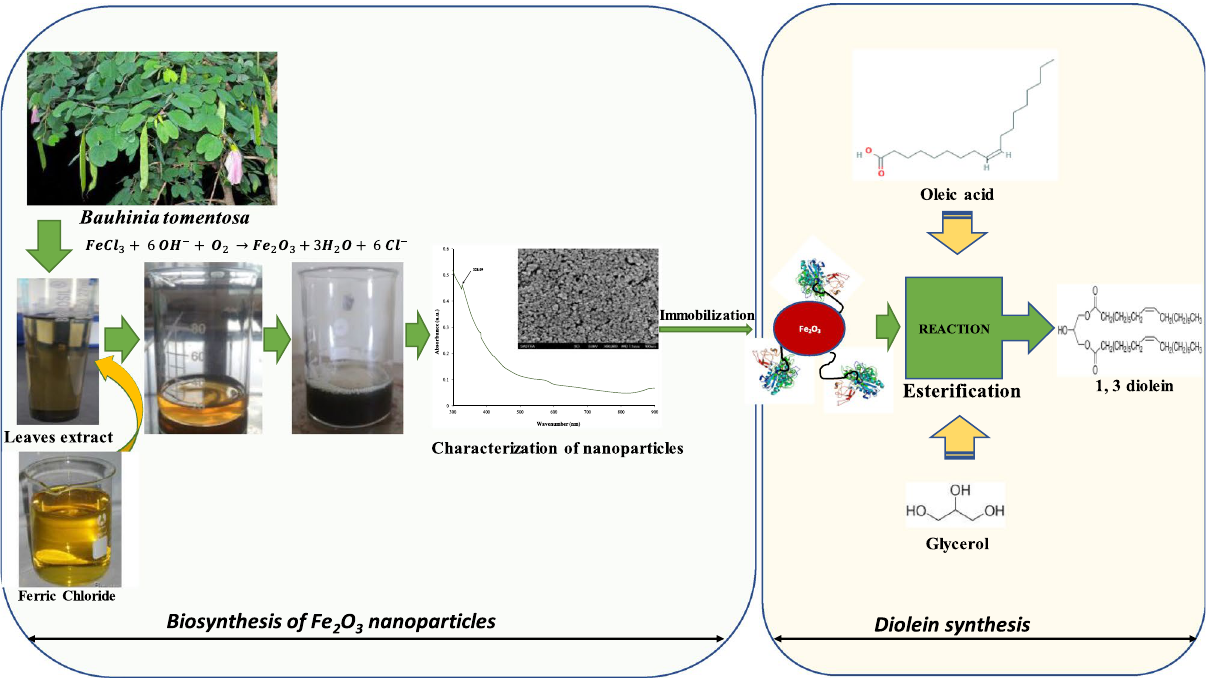
Figure 1. Schematic diagram of synthesis of iron oxide nanoparticles from Bauhinia tomentosa and 1, 3 diolein